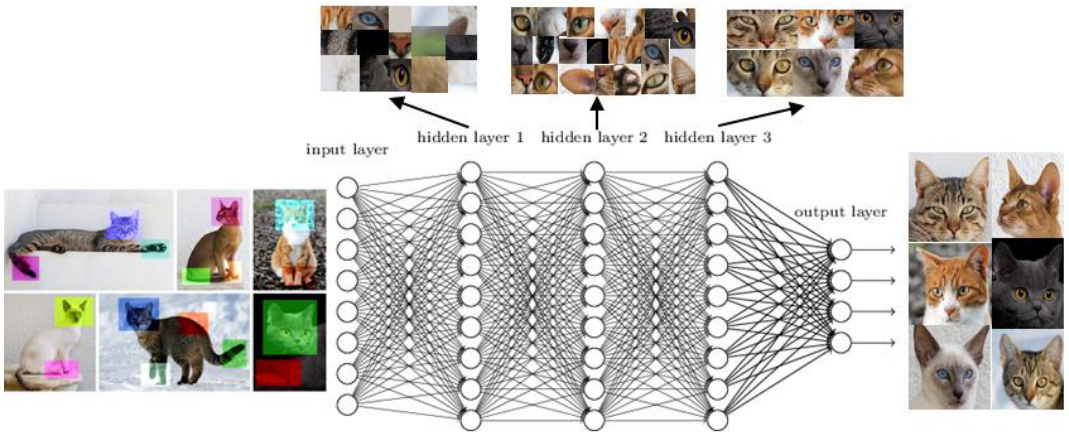
Figure 2 . Example of image recognition based on neural network layers. Figure 2. Example of image recognition based on neural network